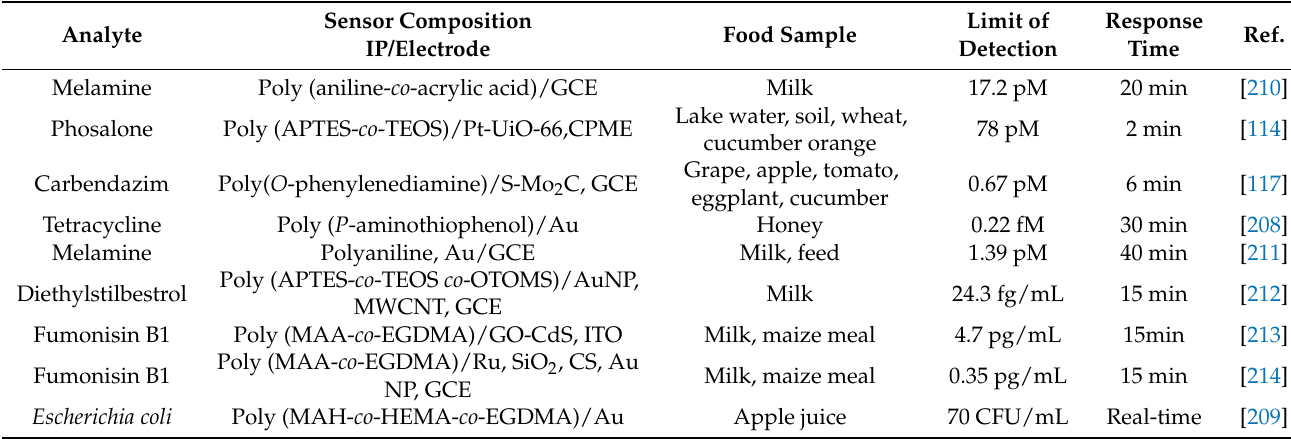
Table 6. Imprinted polymer-electrochemical sensors for food safety.